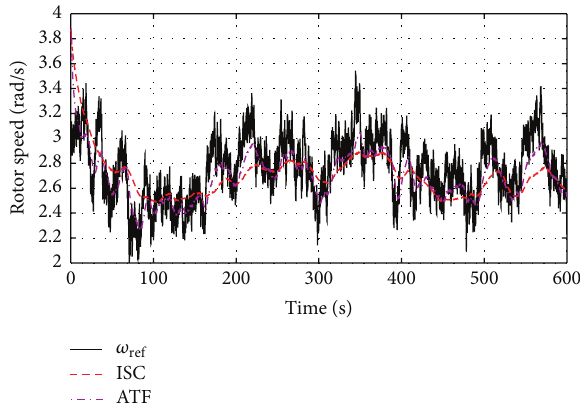
Figure 7: Rotor speed comparison for ATF and ISC for FAST simulator.